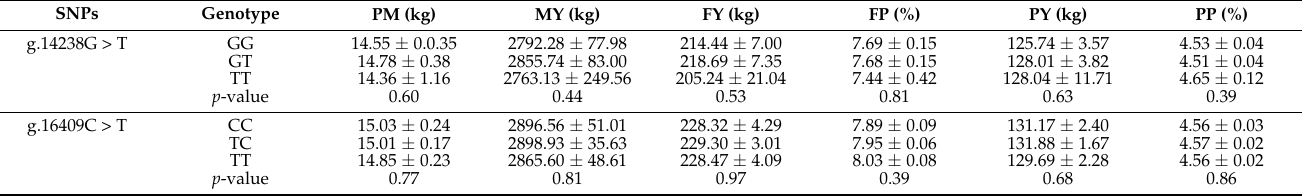
Table 2. Association of SQLE gene polymorphisms and milk production traits in Italian Mediter- ranean